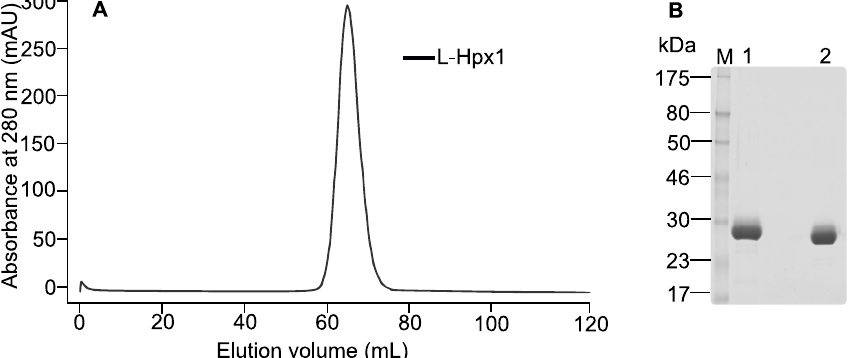
Figure 5. The hemopexin domain of MT1-MMP is monomeric. ( A ) Size-exclusion chromatography elution profile of recombinant L-Hpx domain. ( B ) Coomassie brilliant blue-stained SDS-PAGE analysis of L-Hpx eluted fraction from gel filtration. M: molecular weight marker; lane 1: disulfide bond reduced L-Hpx domain; lane 2: non-reduced L-Hpx domain.